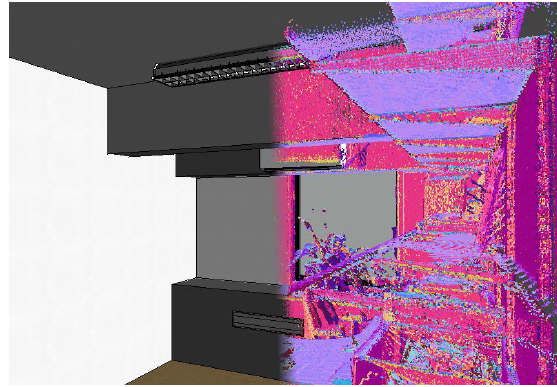
Figure 10. Hybrid showing pointcloud (coloured by normals) and resultant parametric model in a Revit 2014 3D view